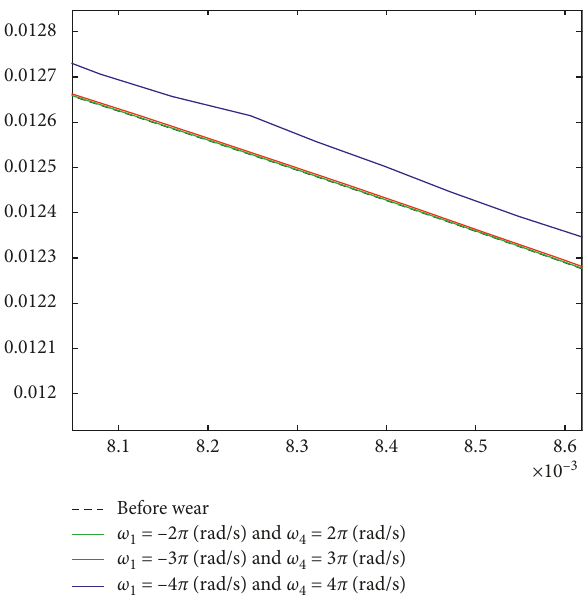
Figure 40: Local enlarged drawing of bearing surface of joint A